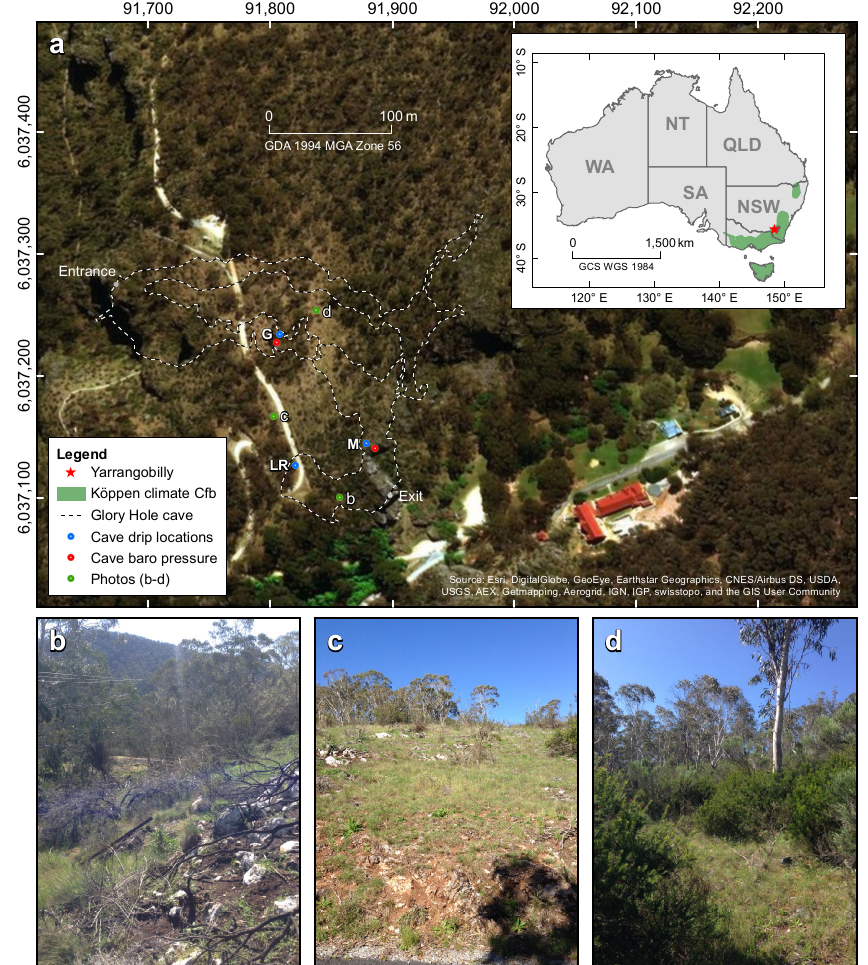
Figure 1. Location of Yarrangobilly Caves in New South Wales, Australia, with photos of surface vegetation (b–d) . Extent of Köppen climate zone is from Peel et al.